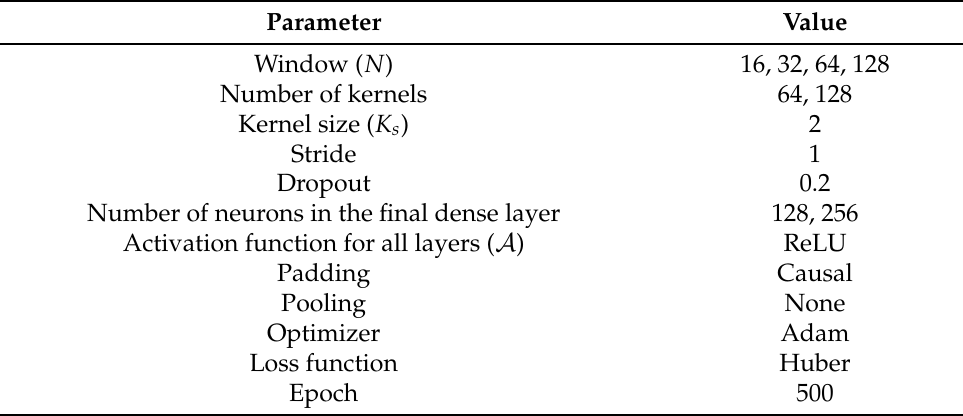
Table 1. Parametric study with the CNN described in Section